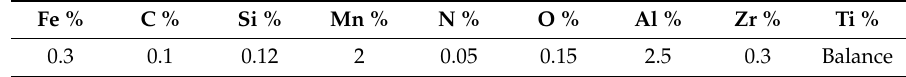
Table 2. Time values for different pressures